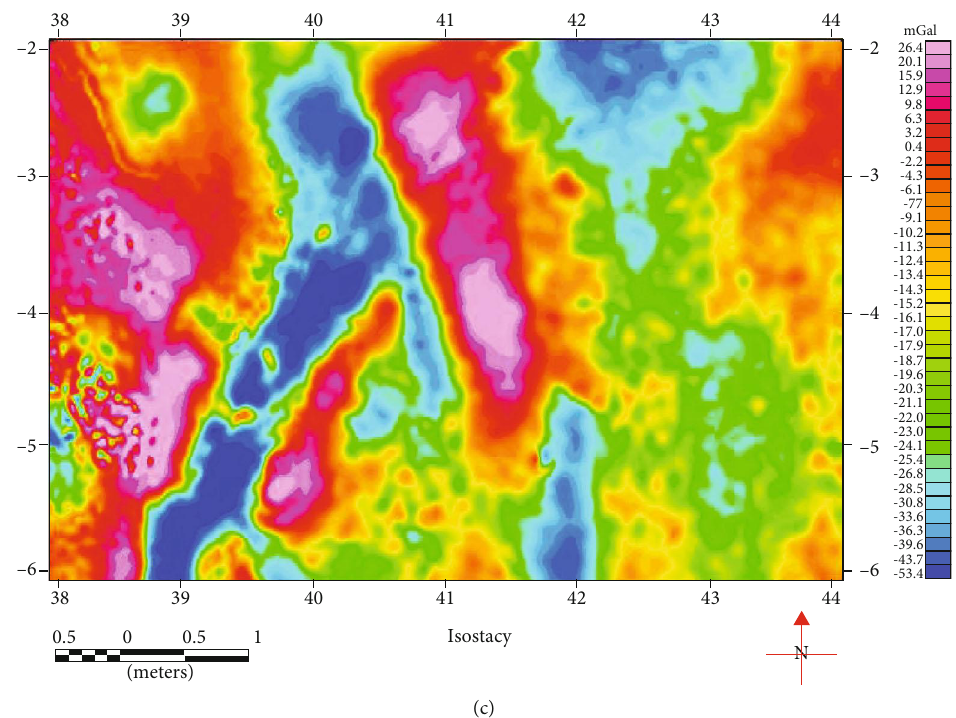
Figure 2: (a) The Bouguer anomaly map shows the coastline, drilled wells, and stations; (b) The free-air anomaly map shows the ridges and troughs; (c) Isostacy anomaly map shows the gravity highs and